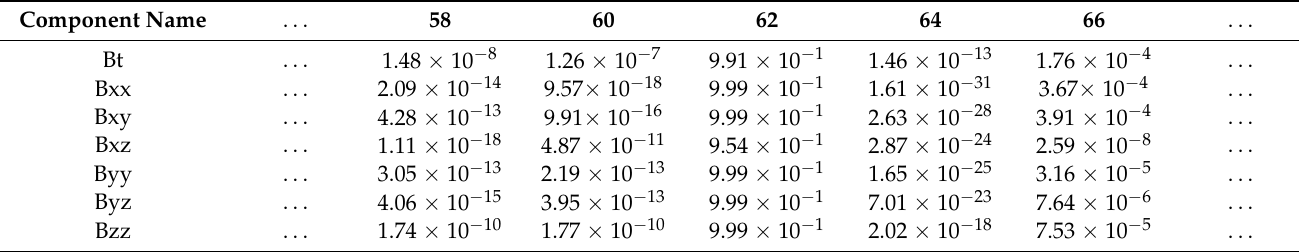
Table 9. Comparison of the prediction accuracies of the total magnetic field and the